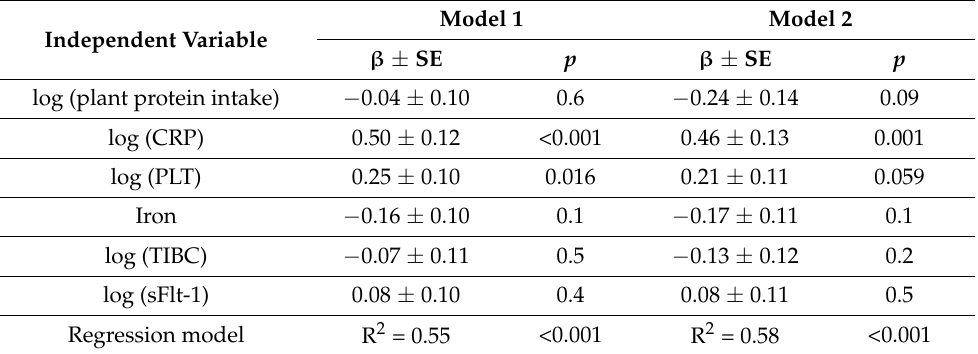
Table 5. Multiple linear regression calculated to assess the variables independently associated with serum AGP (log-transformed serum AGP concentration was the dependent variable). Model 1 (unadjusted) included only the variables significantly associated with log (AGP) in simple analysis, i.e., the variables listed in the Table. Model 2 was additionally adjusted for the following confounders: gender, age, log (dialysis vintage), cardiovascular comorbidity, diabetes, and